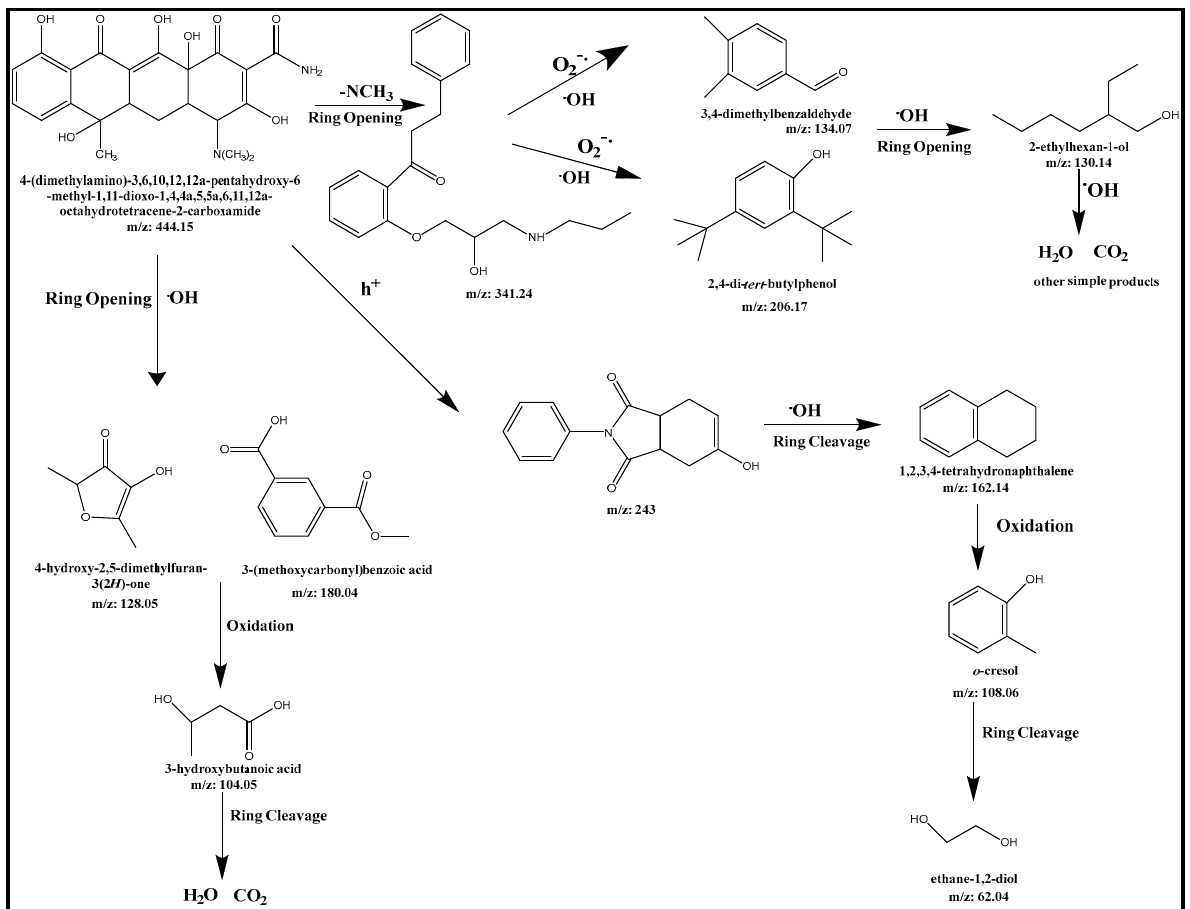
Figure 8. The deteriorated intermediate products formed by the photocatalytic remediation of TC by the 13BVSBS composite.